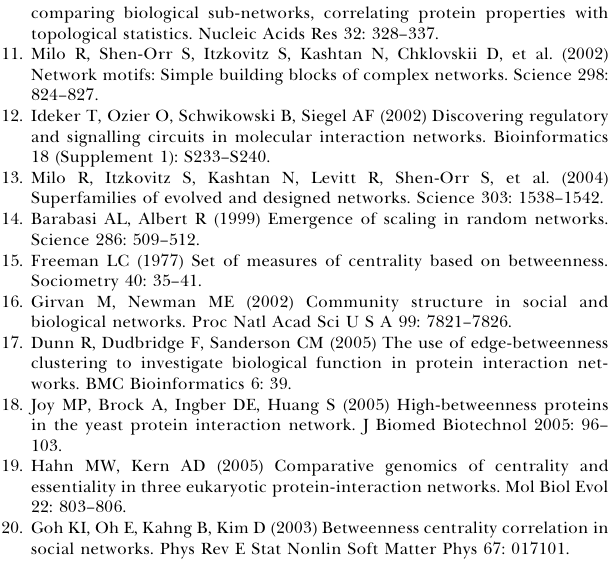
Figure S5. Fraction of Essential Genes among the Four Types of Nodes (i.e., Hub–Bottlenecks, Nonhub–Bottlenecks, Hub–Nonbottle-